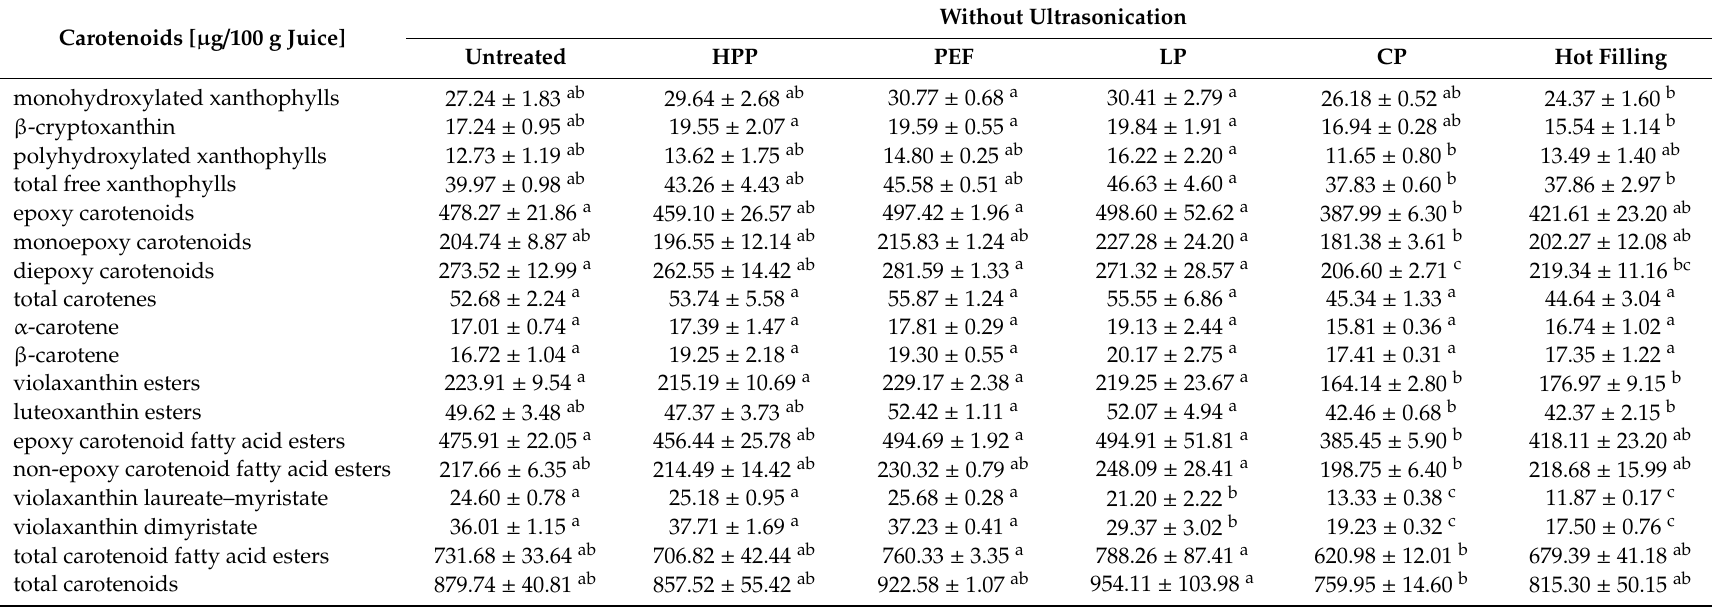
Table 4. Carotenoid concentrations in non-ultrasonicated orange juices. Di ff erent letters indicate significant di ff erences ( p ≤ 0.05). Values are means ± standard deviation ( n =